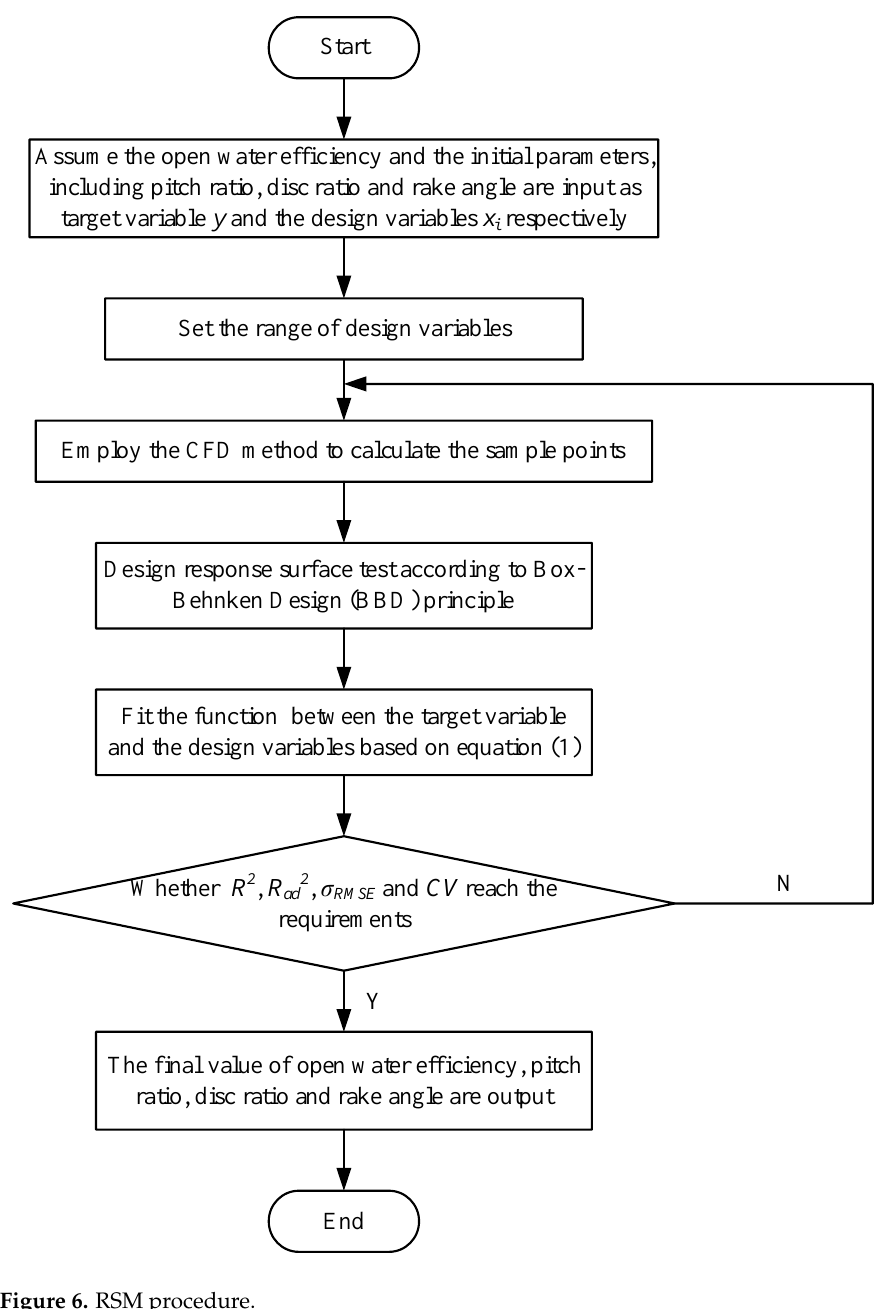
Figure 6. RSM procedure.